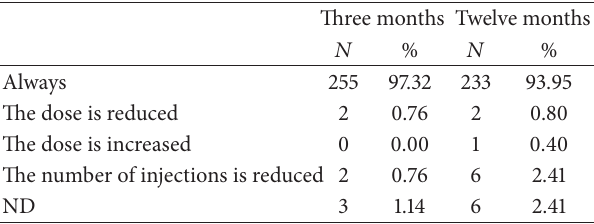
Table 6: “How often is the medication taken according to neurolo- gist prescription?”